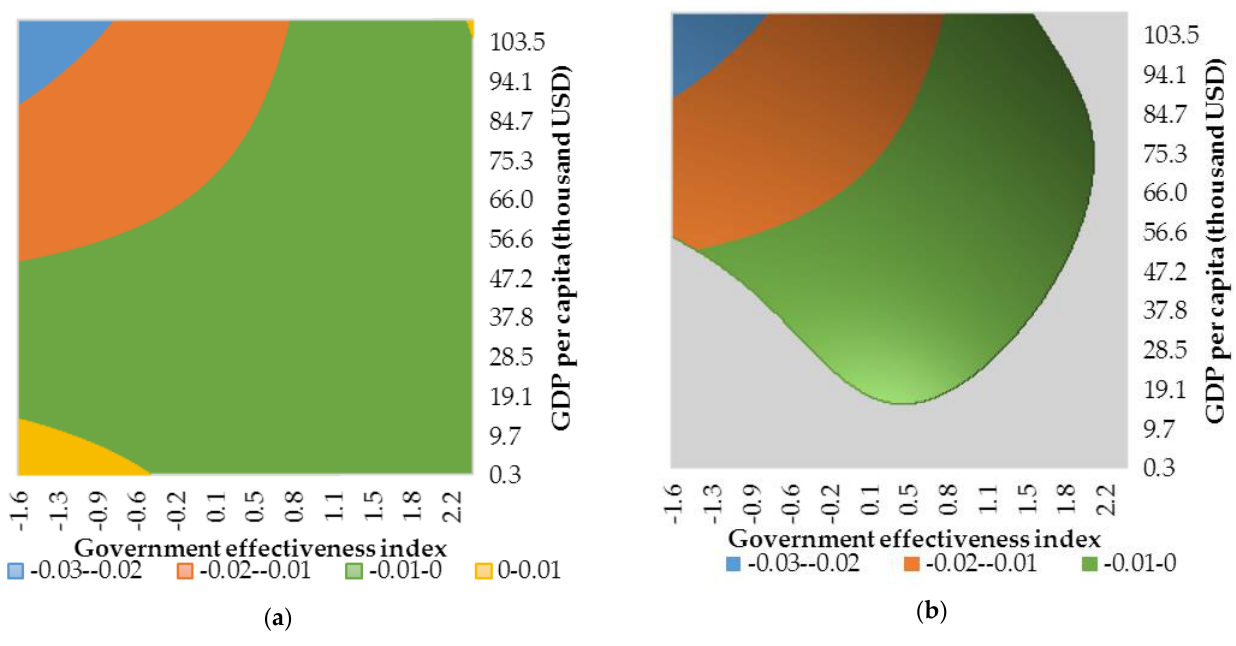
Figure A19. Conditional effect of financialisation on growth based on Est. 19 in Table A2. ( a ) Estimated conditional slope coefficient over the whole range of observed values for institutional quality and development level. ( b ) Estimated statisti- cally significant conditional slope coefficient. Gray represents a combination of institutional quality and development level for which effect of financialisation on growth is statistically insignificant. Source: authors’ contributions.